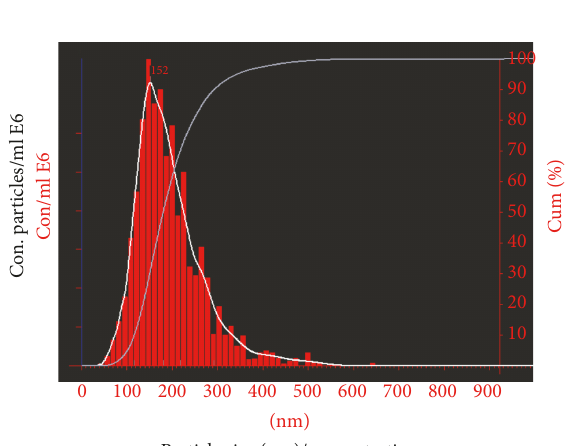
Figure 1: Structure of HBP \ G2.0 (BH20).